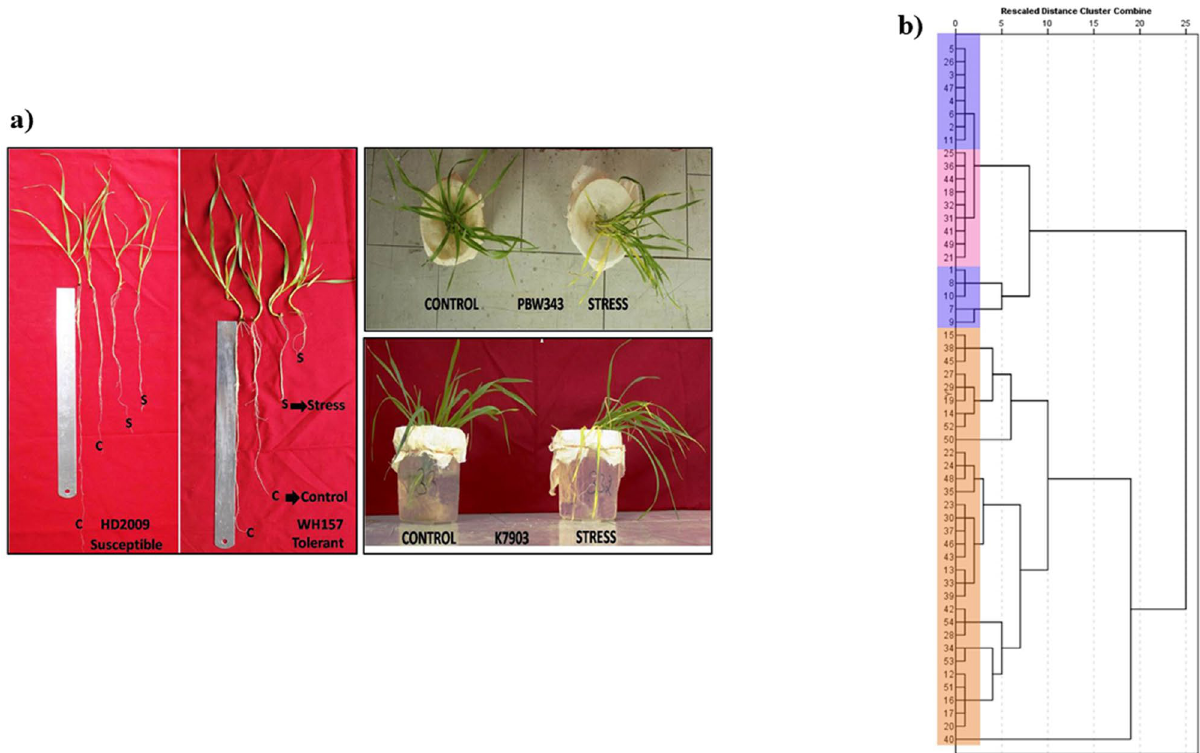
Figure 1. The phenotypic evaluation for salinity tolerance. ( A ) Effect of salt treatment on 54 diverse wheat genotypes under hydroponics conditions, ( B ) dengrogram showing phenotypic variability relationship between 54 wheat genotypes based upon phenotypic data. The cluster is made on the basis of all positive correlation of these traits i.e. total dry weight (TDW), chlorophyll content (SPAD) and sodium content in roots (NA) with salt tolerance index (STI). This dendrogram divides into two major cluster i.e. cluster I and cluster II. Cluster I contains total of 22 genotypes and all the genotypes comes under tolerant and moderately tolerant group. Cluster II contains all susceptible genotypes.